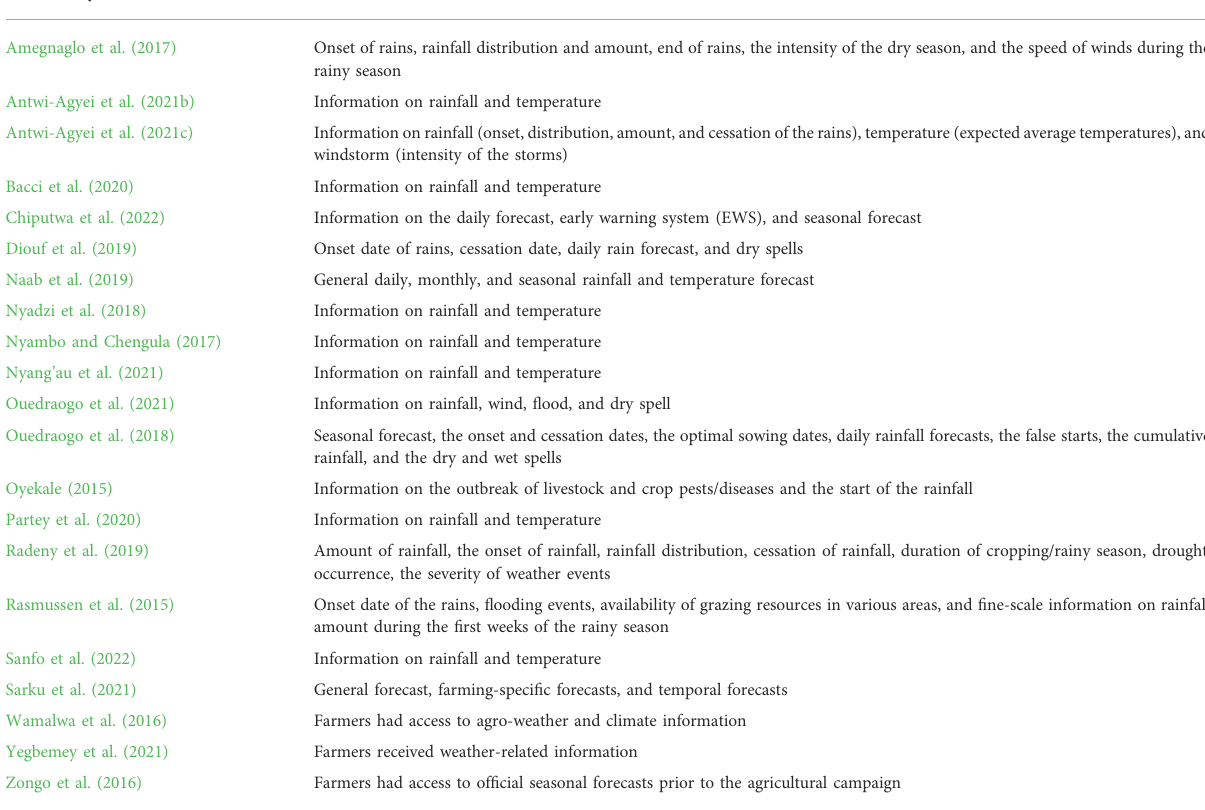
TABLE 2 Summary of the type of weather information accessed by